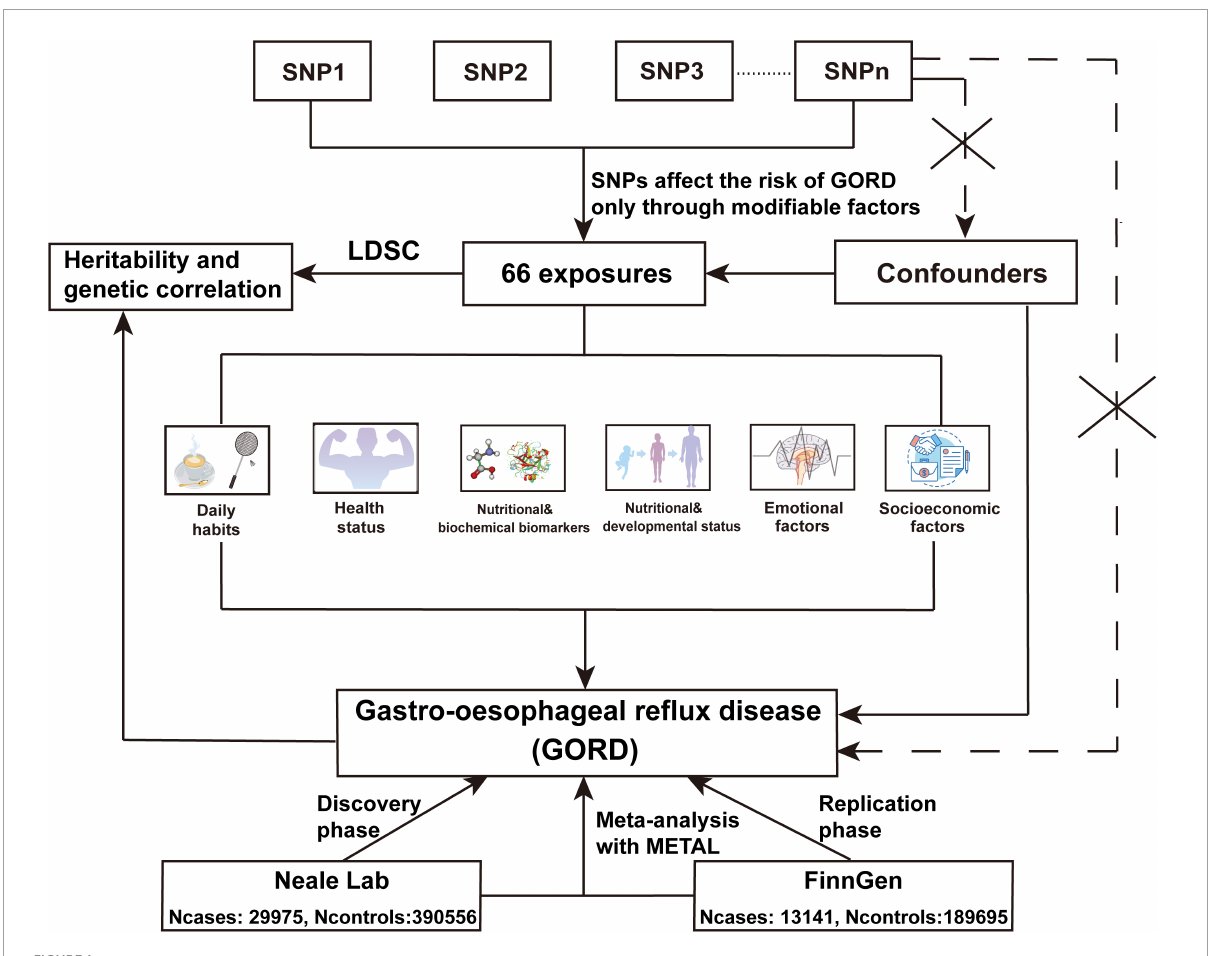
FIGURE1 The flow chart of the UVMR analyses. In UVMR analysis, we assessed the causal associations between 66 exposures across 6 modifiable pathways and the risk of GORD from discovery phase, replication phase, and IVW fixed-effect meta-analysis using METAL for SNPs from GORD Neale and GORD Finn . The selection of IVs (SNPs) abided by 3 assumptions of MR analysis. (1) IVs should be closely related to exposure; (2) IVs cannot affect outcome directly, but only through exposure; (3) IVs should not be associated with the known or unknown